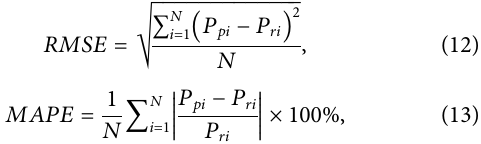
FIGURE 4 | Predicted power curves of three neural networks.